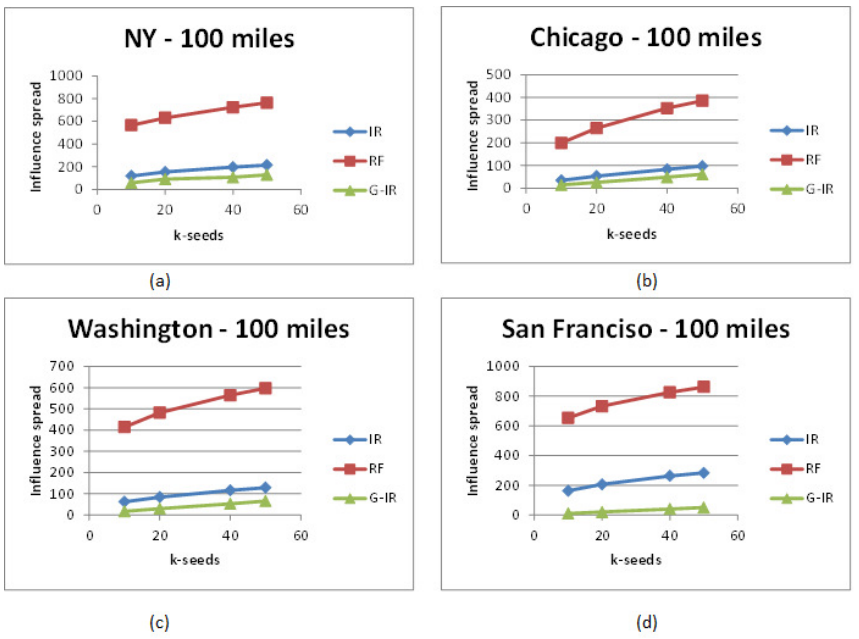
Figure 3. Influence spread on various regions on Gwalla dataset.